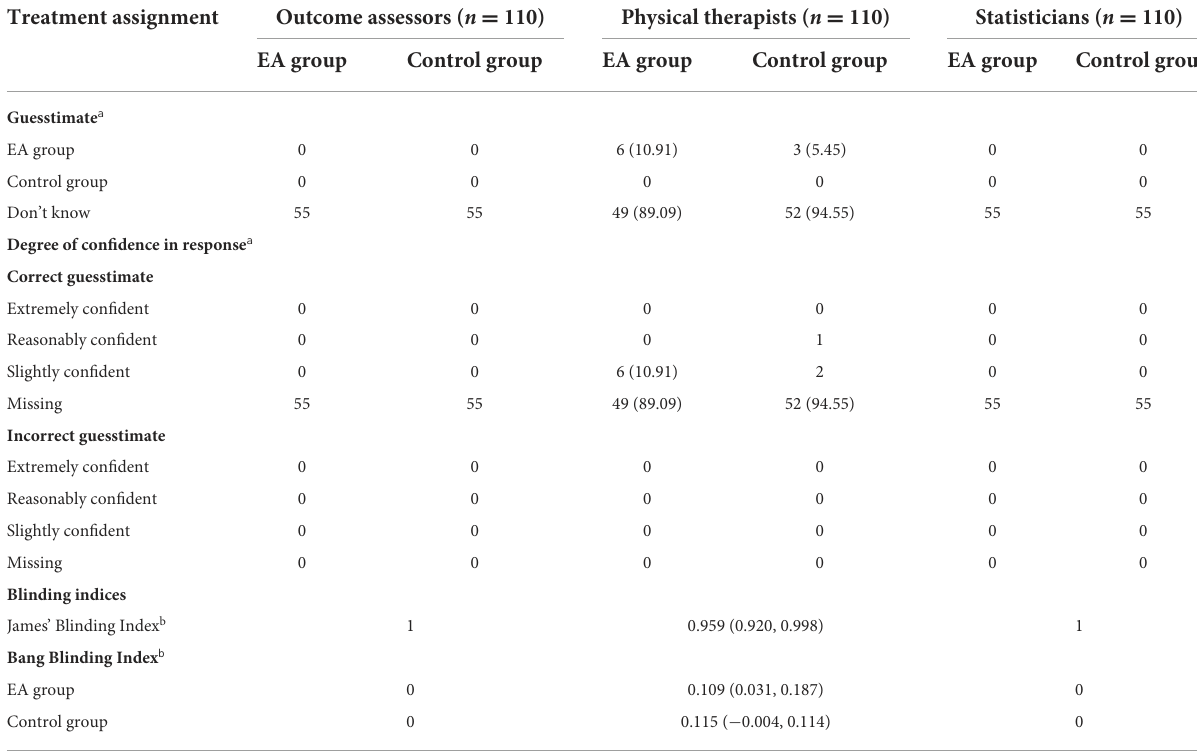
TABLE 3 Guesstimate vs. treatment